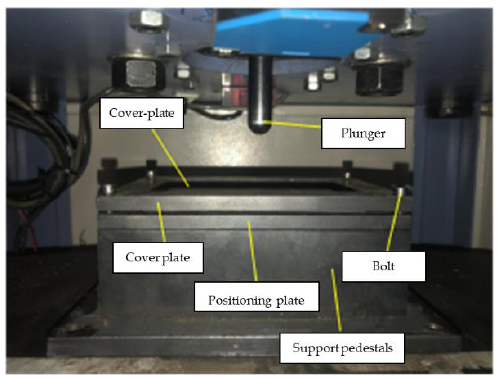
Figure 2. The test device of Low- velocity impact